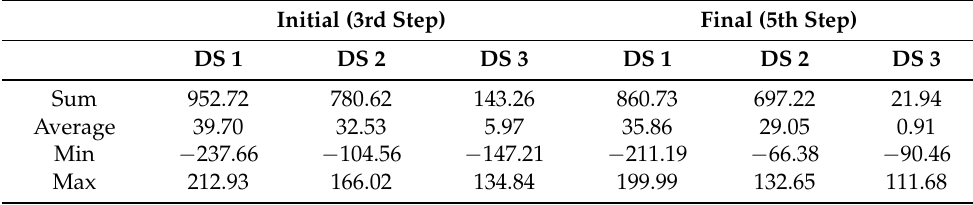
Table 1. Energy transferred in PCCs in the 3rd (initial) and 5th (final) steps in scenario